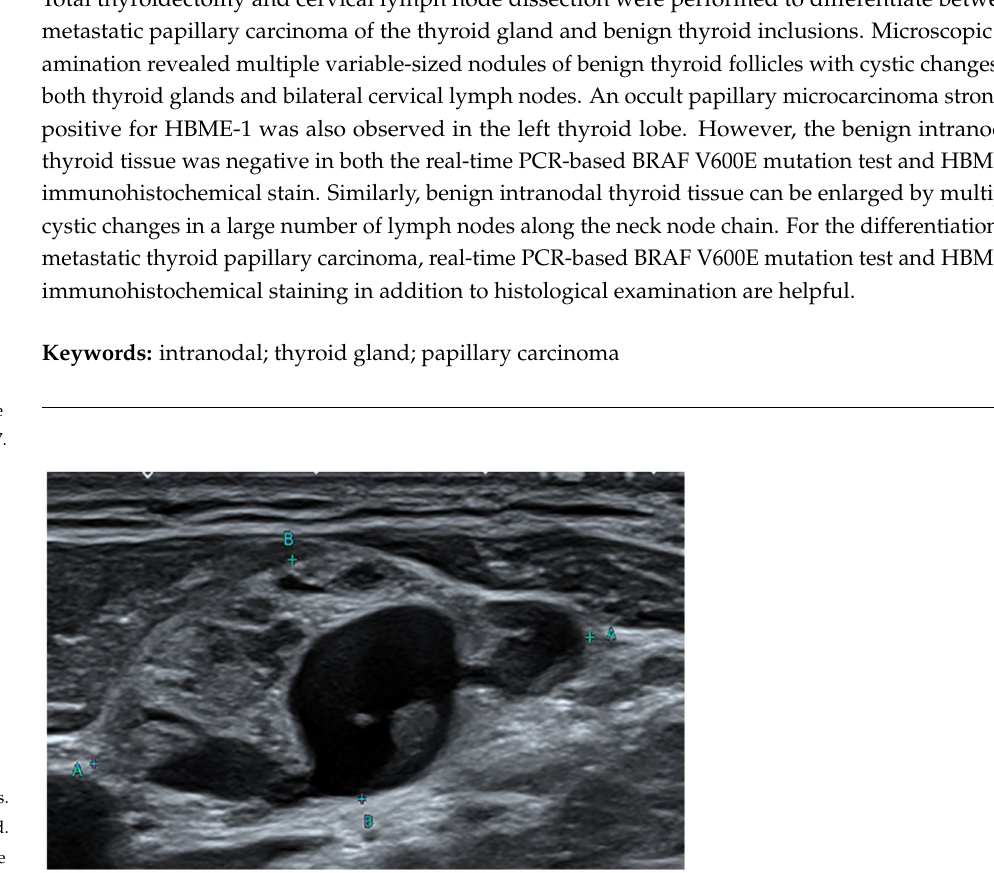
Figure 1. Ultrasound sonography (US) of the neck. Neck US reveals an enlarged lymph node with internal cystic change at left level III. A few cases of non-malignant inclusions were detected in lymph nodes removed from a patient with malignancies. For example, benign salivary glands in the pulmonary hilar lymph node, benign epithelial tissue, nevus cells in the axillary node, and